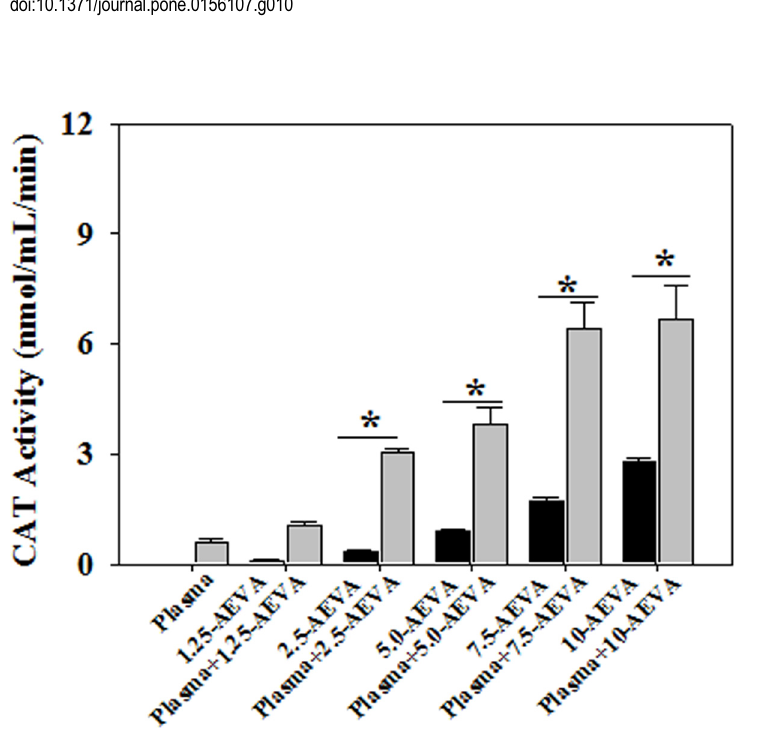
Fig 11. Effect of AEVA on CAT activity in human plasma. 100 μ L of human plasma (collected from normal subject) was incubated with different concentration of AEVA (1.25, 2.50, 5.00, 7.50, and 10.00 μ g μ L -1 ) for 2 h at 37°C. “ * ” indicates the significant difference between “ AEVA alone ” and “ plasma + AEVA ” at the respective concentration of AEVA ( p < 0.05). Values are mean ± SE (n =